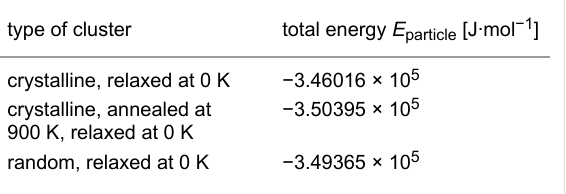
Table 1: Total energy of Au 55 clusters after relaxation at 0